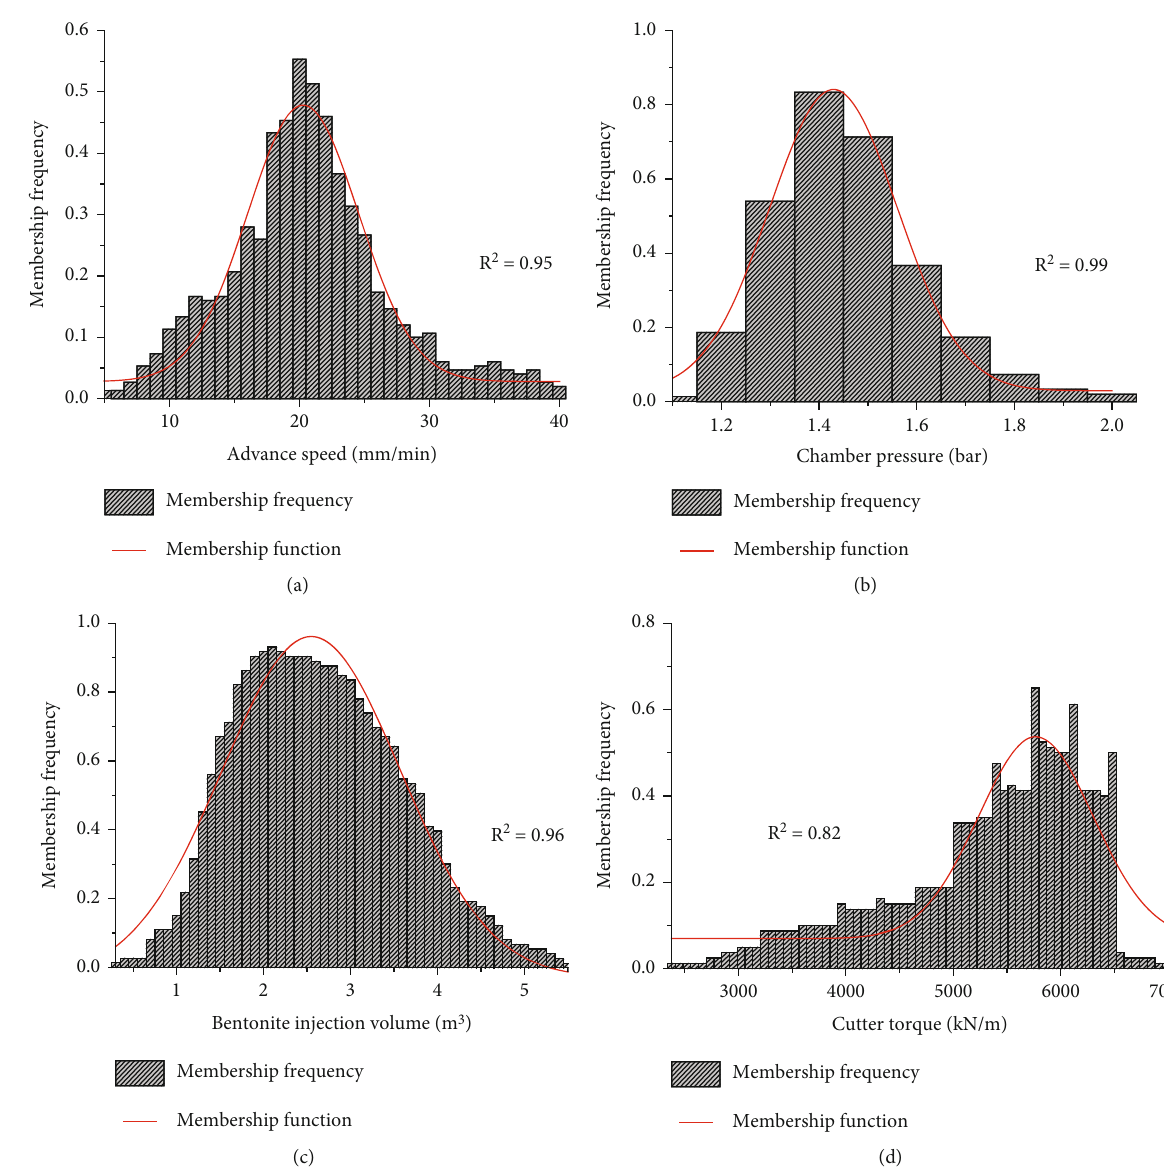
Figure 18: The membership frequency and the membership function of the driving